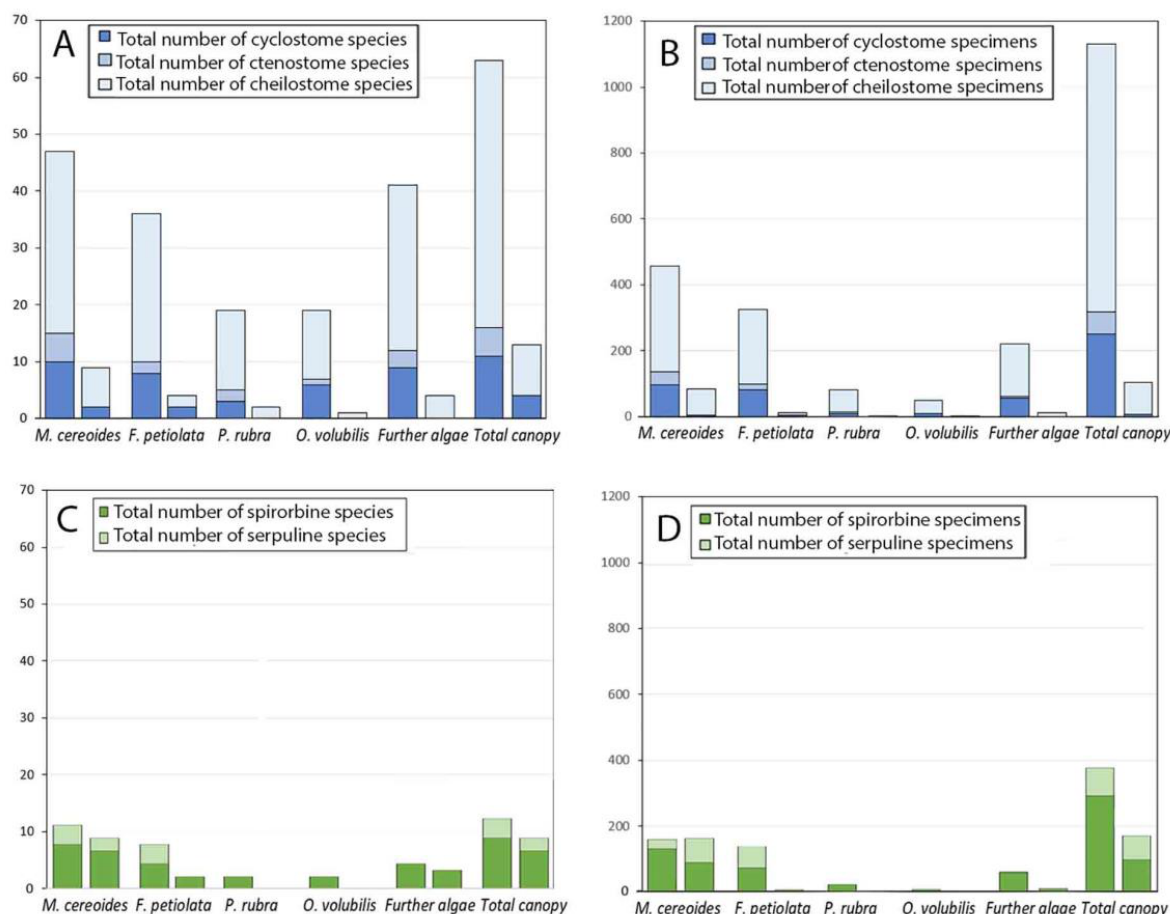
Figure 3. Relevance of taxonomic groups within bryozoan and serpulid epibiont assemblages found on the bryozoan Margaretta cereoides and the main algae of the canopy on the build-up E collected offshore Marzamemi (Ionian Sea). For each substrate the left column refers to living and the right one to dead assemblages. ( A , B ) Relevance of cyclostome, ctenostome and cheilostome bryozoans at species ( A ) and colony ( B ) level. ( C , D ) Relevance of serpulin and spirorbin serpulids at species ( C ) and specimen ( D )